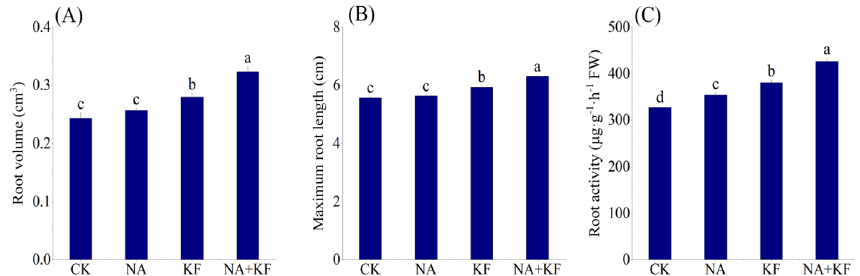
Figure 2. Effects of different treatments on root parameters of tomato seedlings. ( A ) Root volume, ( B ) maximum root length, ( C ) root activity, NA, 5 mg·kg −1 NA; KF, 60 mg·kg −1 KF; NA + KF, 5 mg·kg −1 NA and 60 mg·kg −1 KF. Different lowercase letters denote statistical differences among treatments of tomato seedlings at the 5% level according to LSD test. Error bars above mean indicate standard error (n = 3).